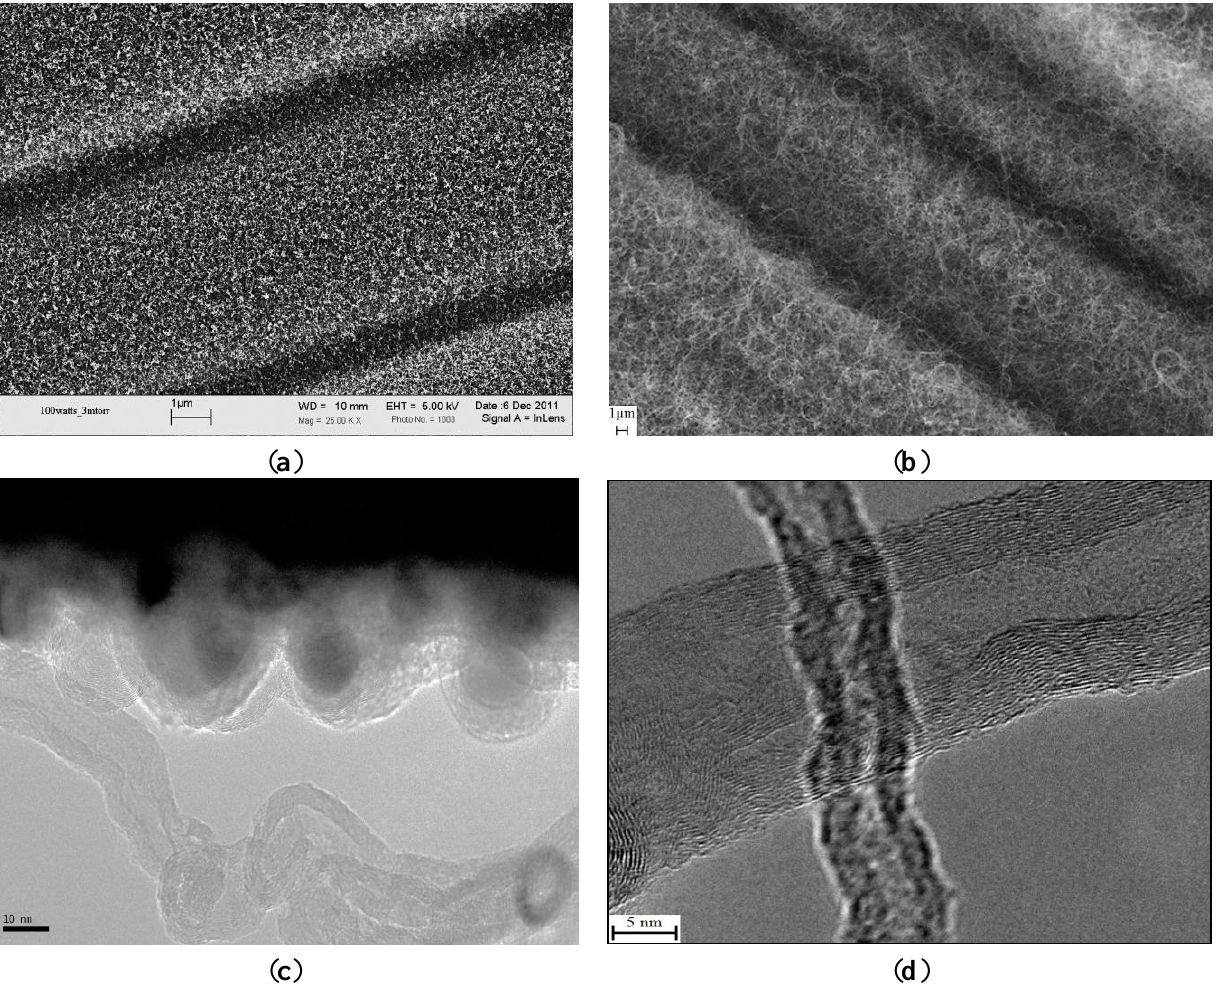
Figure 2. The SEM micrograph of nanofilaments grown via ( a ) GSD and ( b ) chemical vapor deposition (CCVD); The TEM micrograph of the morphologies of nanofilaments grown via ( c ) GSD and ( d ) CCVD.